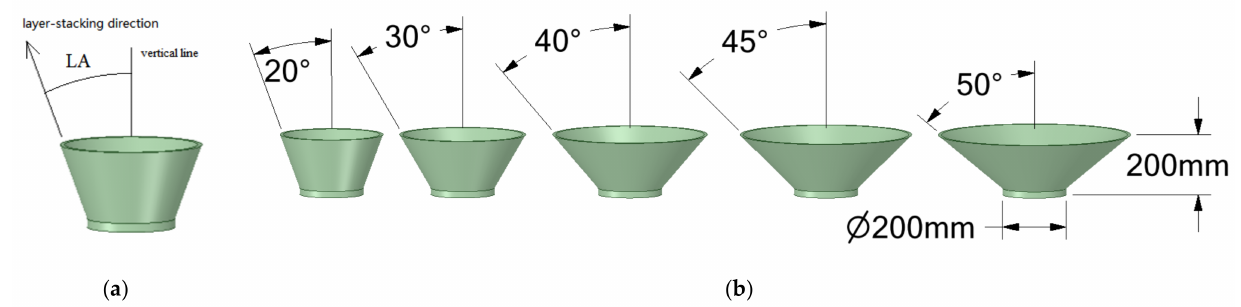
Figure 8. The leaning angle tests. ( a ) The definition of the leaning angle and ( b ) sketch designs for multi-angle